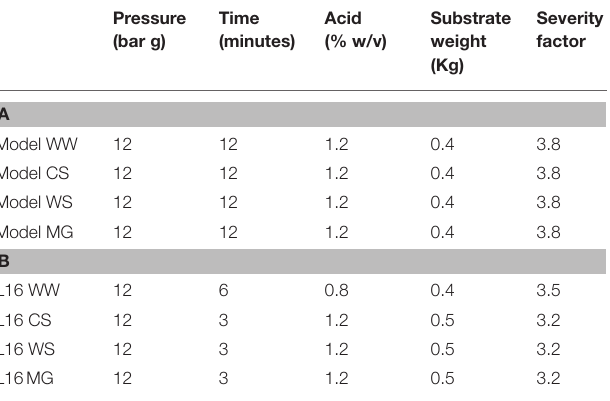
TABLE 5 | Severity index interactions between factors for xylose release from SE-PT of feedstock. Interacting factor pairs SI (%) Col Opt Corn stover